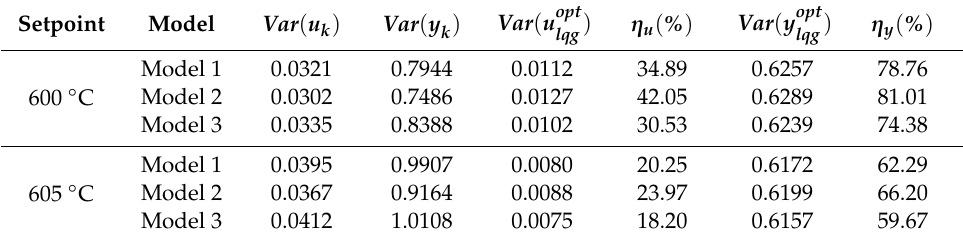
Table 1. Statistical Results of Steady State